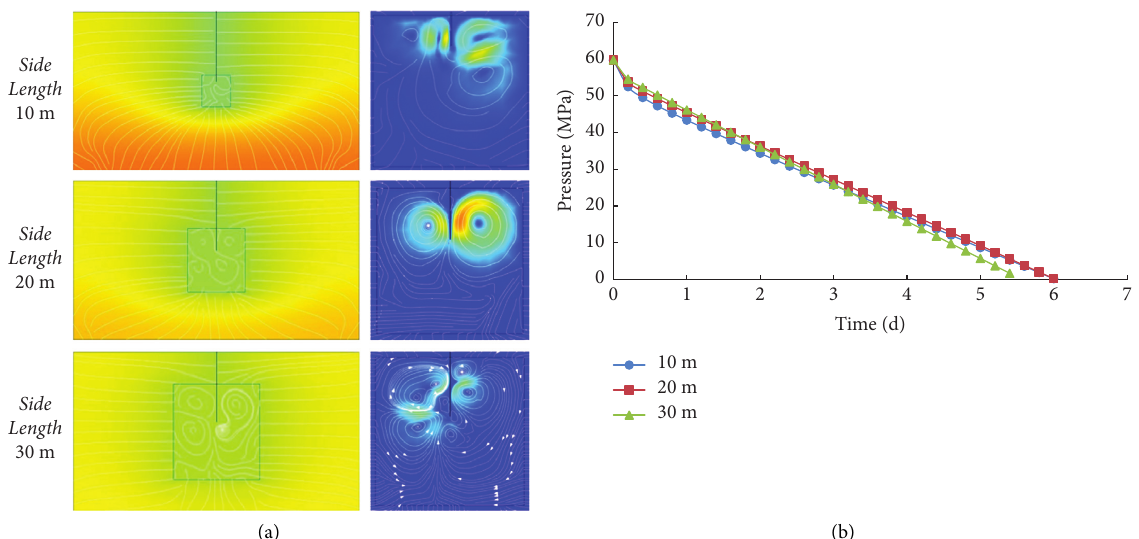
Figure 10: Distribution of pressure and velocity field with different sizes of fractures (a) and pressure of different fractures and hole sizes with production time (b).